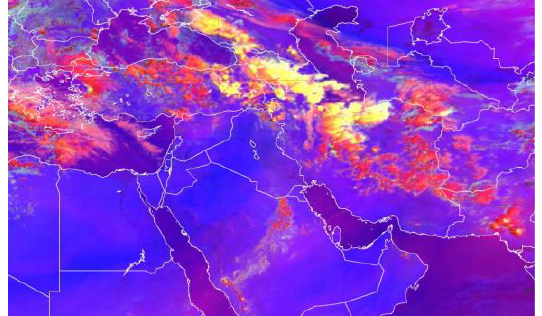
Figure 4. Convection governing over Iran on 12UTC just before the storm starts. Cumulus